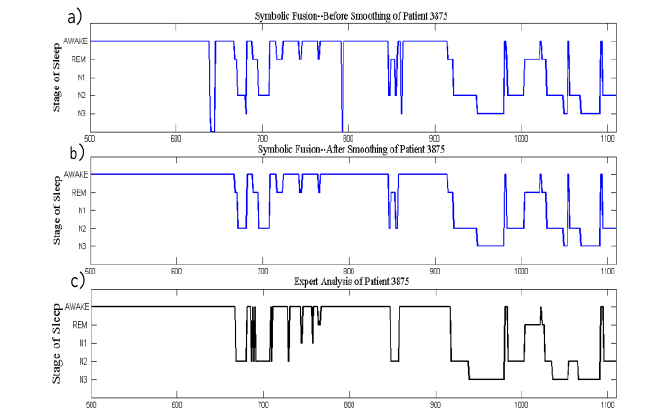
Figure 4. Hypnograms comparison between symbolic fusion